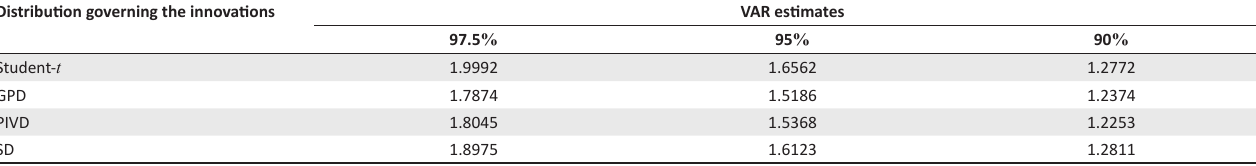
TABLE 7: Value-at-risk estimates for the asymmetric power auto-regressive conditional heteroscedastic (1,1) model combined with different distributions. Distribution governing the innovations